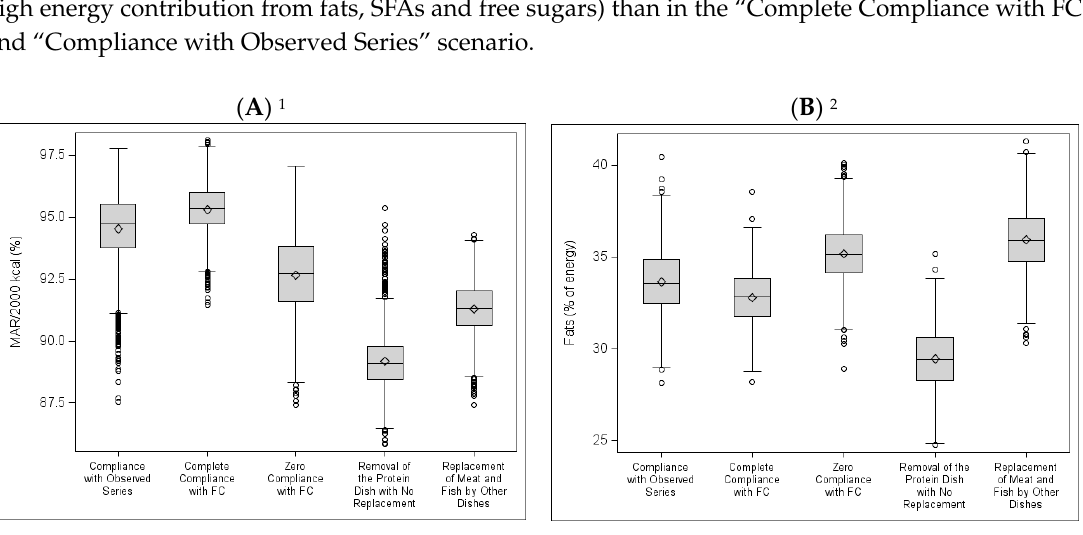
Figure 4. Nutritional quality of simulated series according to five scenarios: Box Plots ( A ) Mean Adequacy Ratio (MAR, % of adequacy for 2000 kcal); ( B ) Fats (% of energy); ( C ) Saturated Fatty Acids (SFAs, in % of energy); ( D ) Free Sugars (% of energy). 1 For MAR/2000 kcal, the averages are statistically different ( p < 0.05) from one series to another. 2 For fats (% of energy), the averages are statistically different ( p < 0.05) from one series to another, except between “Zero Compliance with FC” and “Replacement of Meat and Fish with Other Dishes”. 3 For SFAs (% of energy), the averages are statistically different from one series to another ( p < 0.05). 4 For free sugars (% of energy), the averages are statistically different ( p < 0.05) from one series to another except between “Complete Compliance with FC” and “Compliance with Observed Series”, and between “Complete Compliance with FC” and “Replacement of Meat and Fish with Other Dishes”. In addition, in the “Complete Compliance with FC” series, the standard deviation of the MAR/2000 kcal was significantly lower than in the other series, suggesting that compliance with FC can prevent the occurrence of series with low MAR/2000 kcal values. The “Zero Compliance with FC” series had lower nutritional quality (lower MAR/2000 kcal, plus high energy contribution from fats, SFAs and free sugars) than in the “Complete Compliance with FC” and “Compliance with Observed Series” scenario. In the “Removal of the Protein Dish with No Replacement” series, the energy contribution from fats and SFAs was lower than in the other simulated series, the MAR/2000 kcal was significantly lower, and the energy contribution from free sugars was higher. The “Replacement of Meat and Fish with Other Dishes” series were those in which the energy contribution from SFAs was highest, as was the contribution from fats, which was as high as in the